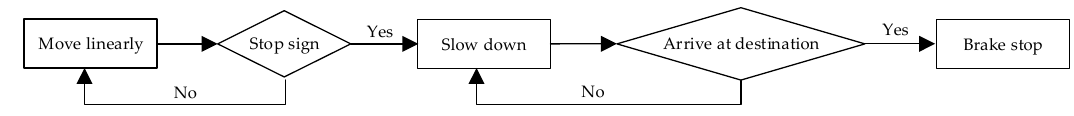
Figure 11. Control strategy of accurate stop.